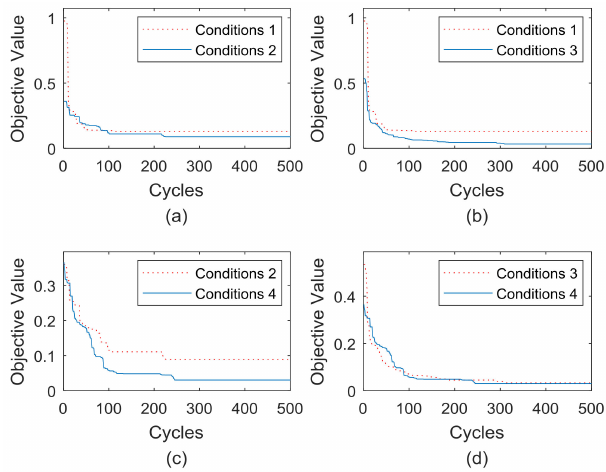
Figure 9. Horizontal comparison of the 4 conditions; ( a ) Comparison of Conditions 1 & 2; ( b ) That of Conditions 1 & 3; ( c ) That of Conditions 2 & 4; ( d ) That of Conditions 3 & 4.